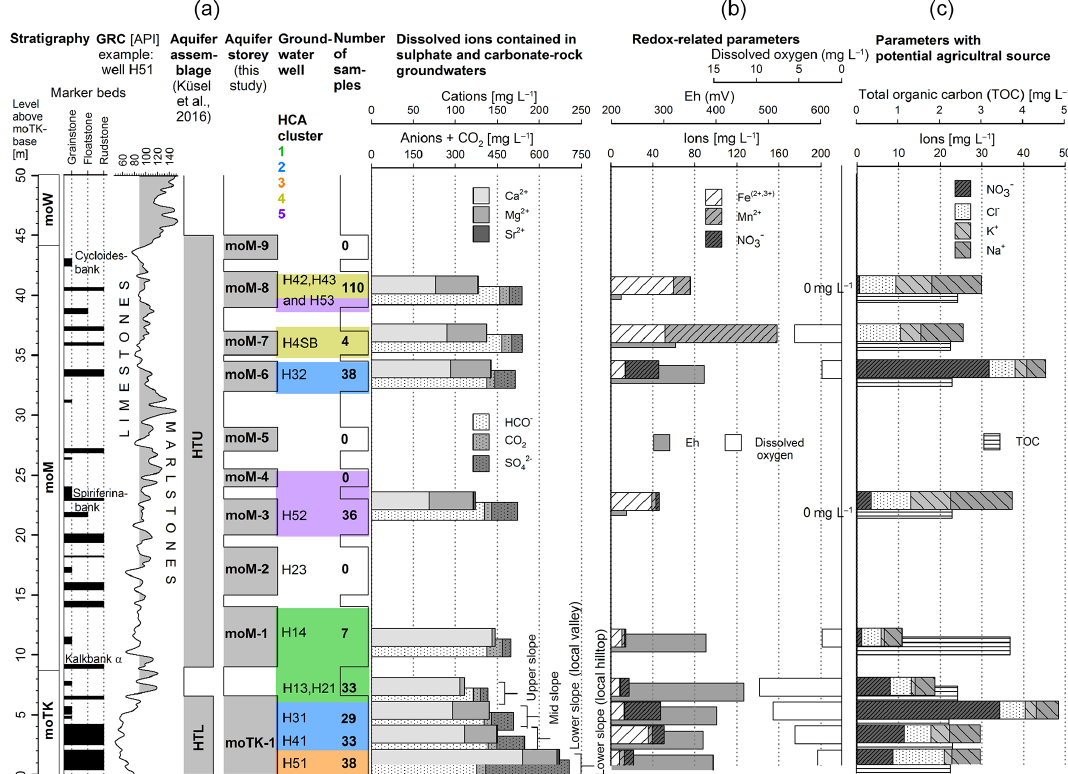
Figure 6. Stratigraphic succession of the Upper Muschelkalk with stratigraphic marker beds (a) , a gamma-ray log, aquifer assemblages HTL/HTU, aquifer storeys moTK-1 to moM-9 and the average chemical compositions of monitored groundwater ( a : ions related to carbon- ate/sulfate minerals; b : redox-sensitive ions; c : ions which are potentially related to the type of land management). The colour code of the hierarchical clusters is identical to Fig. 4.